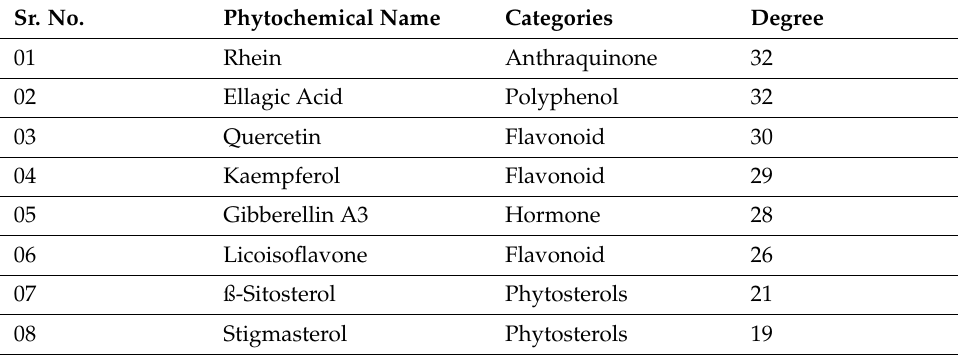
Table 2. Degrees of 8 active constituents analyzed by the Cytoscape. Sr.